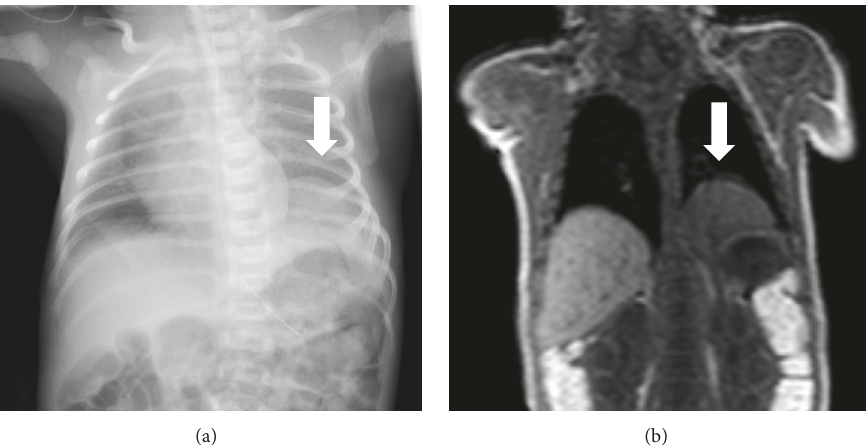
Figure 1: (a) A chest X-ray showed eventration of the left hemidiaphragm (arrow) on the first day after birth. (b) Magnetic resonance imaging revealed left sac-type CDH (arrow) at 21 days after birth.